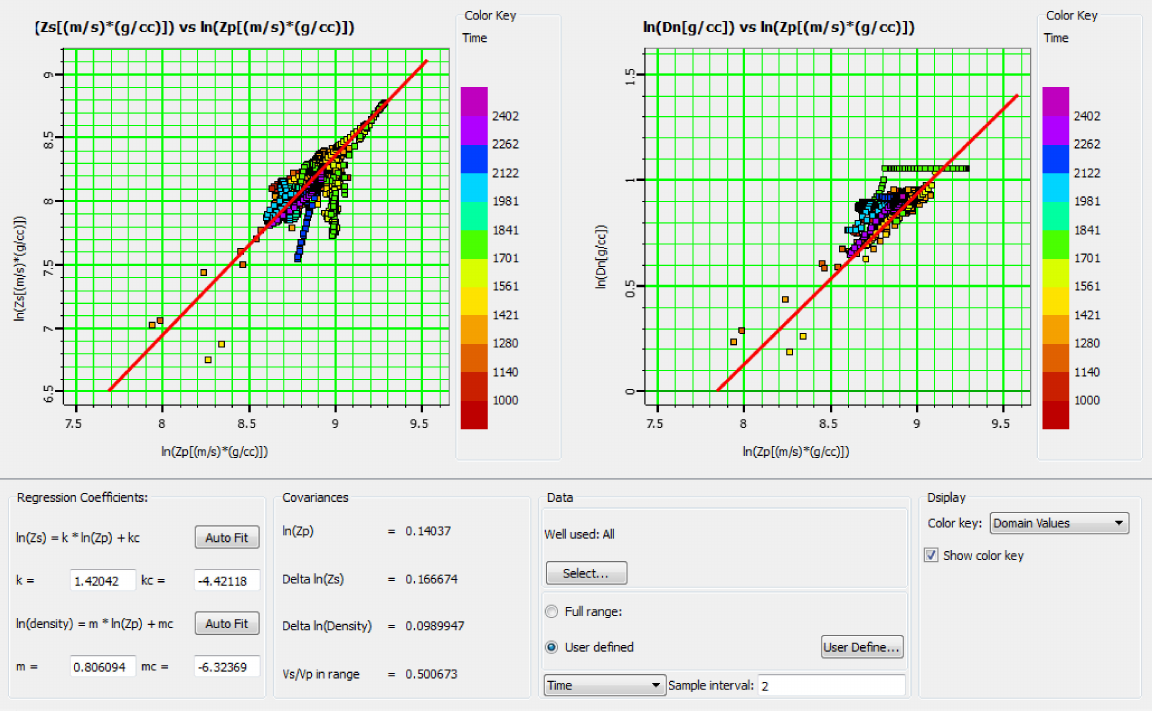
Figure 8. Regression coefficients, as determined from elastic rock property cross plot. The outputs of simultaneous inversion of P-impedance, S-impedance, density, and Vp/Vs ratio were further implemented to generate 3D cubes of SQp and SQs attributes. Additionally, these outputs were also used for further ANN